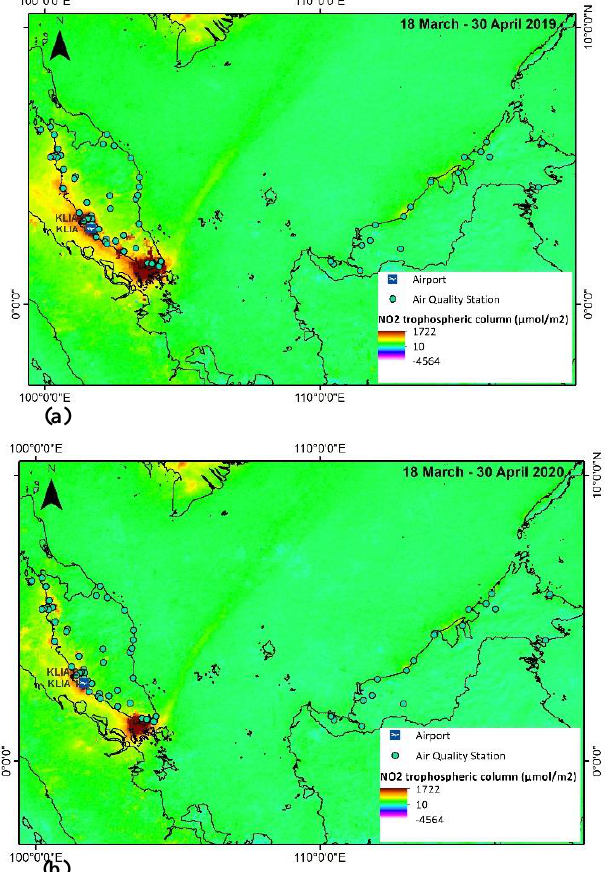
Figure 2. Spatial distribution of NO 2 tropospheric column amounts in Malaysia for March-April 2019(a) and 2020